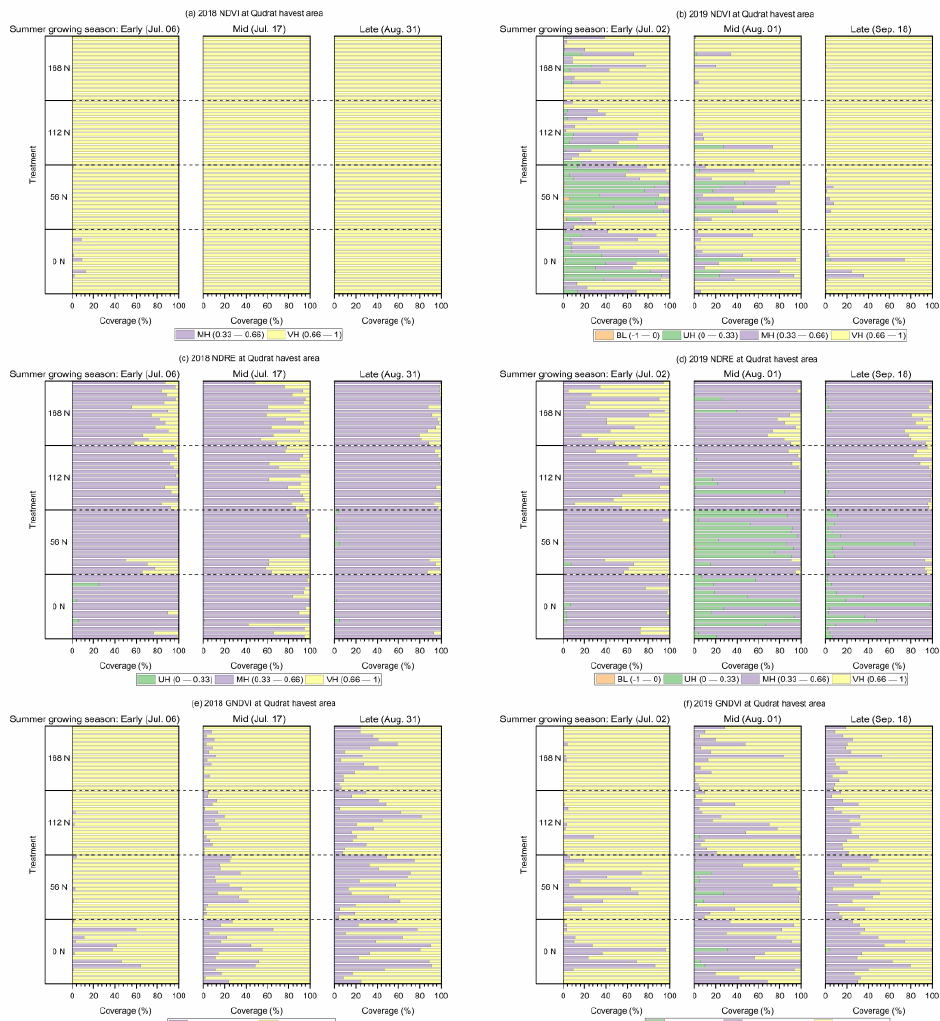
Figure 4. Plant stand health condition coverage corresponding to the reclassified vegetation indices in quadrat-harvested areas in 2018 and